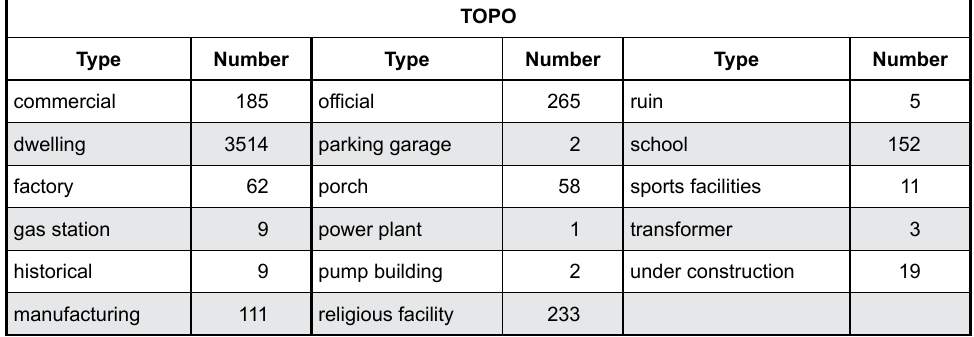
Table 3. Semantic types and numbers of BFs in the TOPO match table